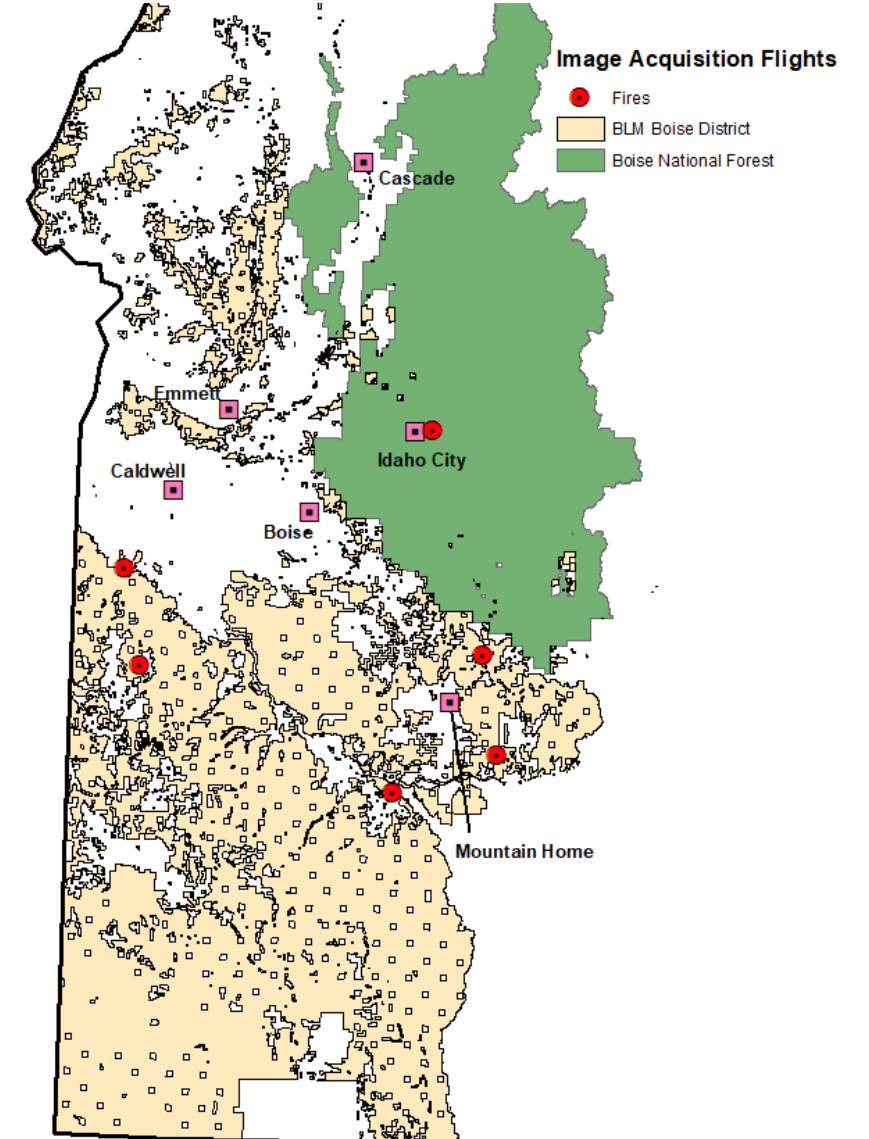
Figure 1. Geographic distribution of wildland fires over which post-suppression image acquisition flights were conducted in southwestern Idaho.